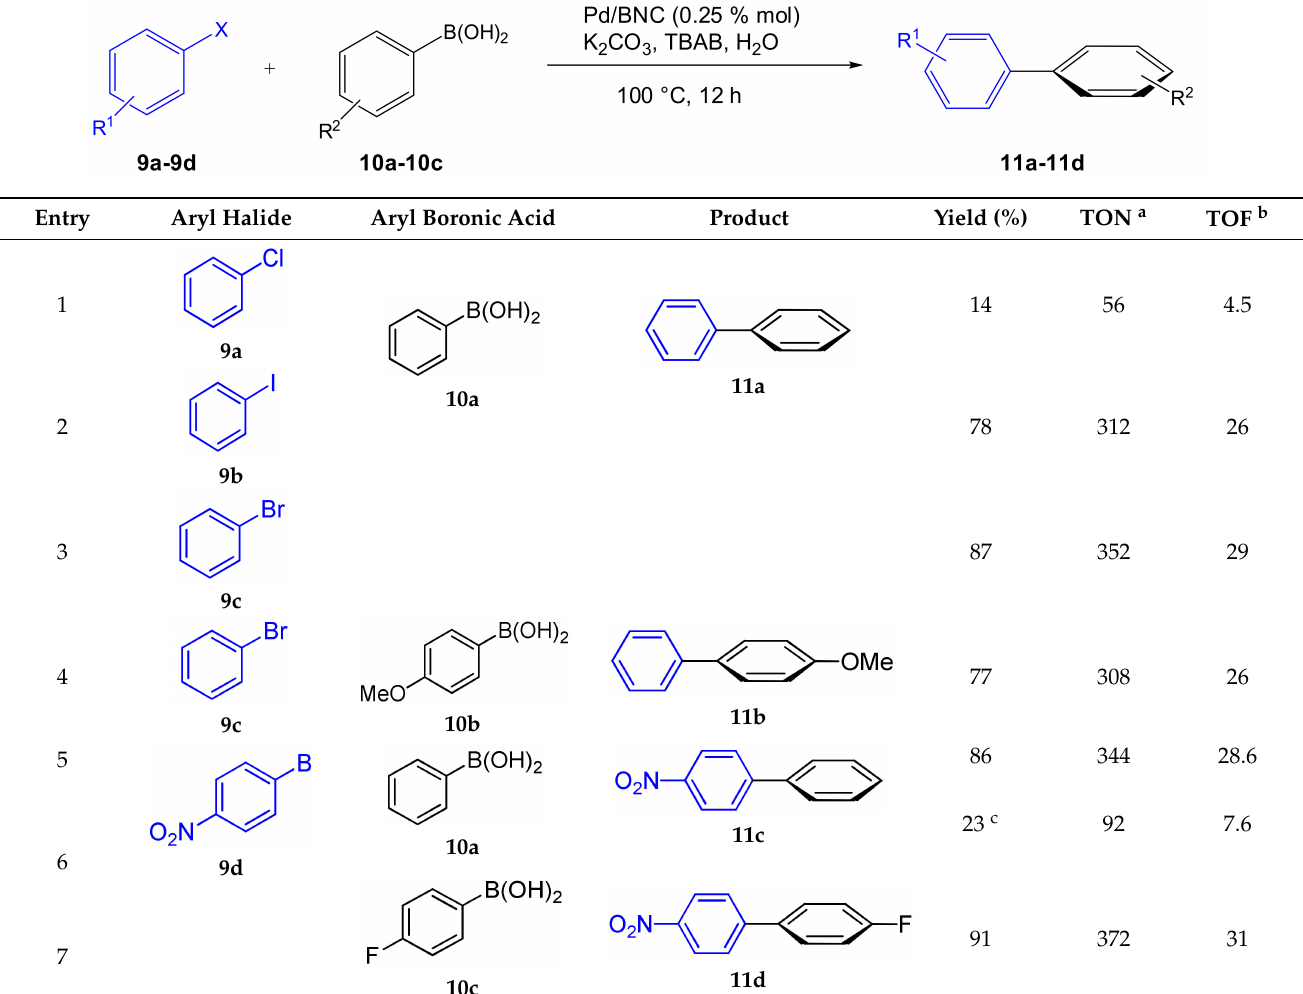
Entry Aryl Halide Aryl Boronic Acid Product Yield